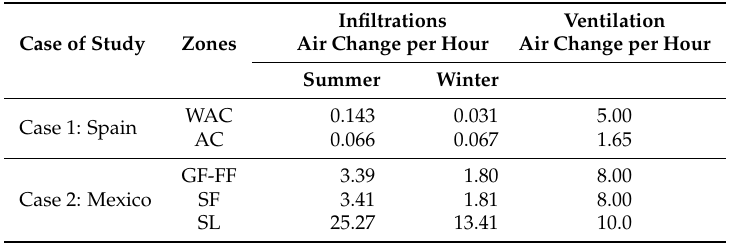
Table A4. Infiltrations and ventilation for each zone in summer and